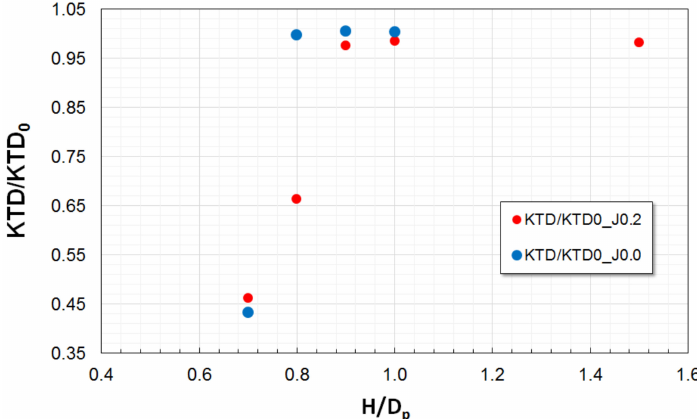
Figure 27. Variations in propeller thrust, KTD, with propulsor submergence, H/Dp, at J = 0.2 and J = 0.0. (KTD 0 refers to the corresponding value in unbounded